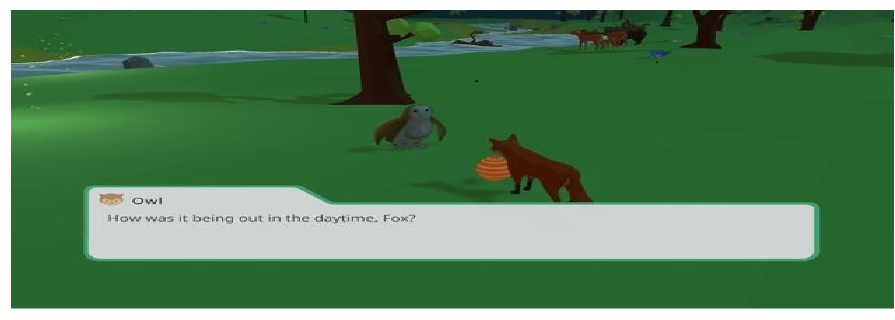
Figure 4. Prism App [40].